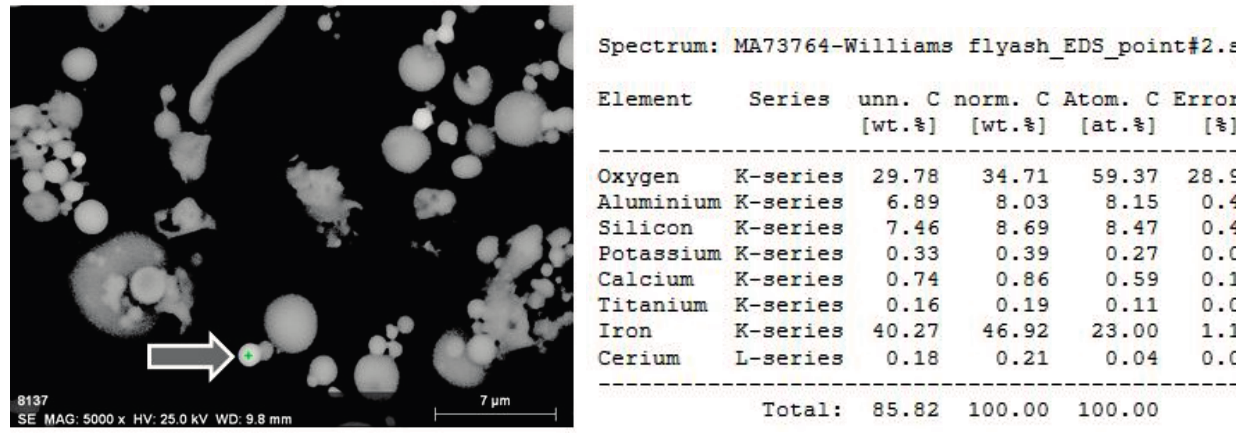
Figure 2. Scanning electron microscope image of plant W fly ash with accompanying element